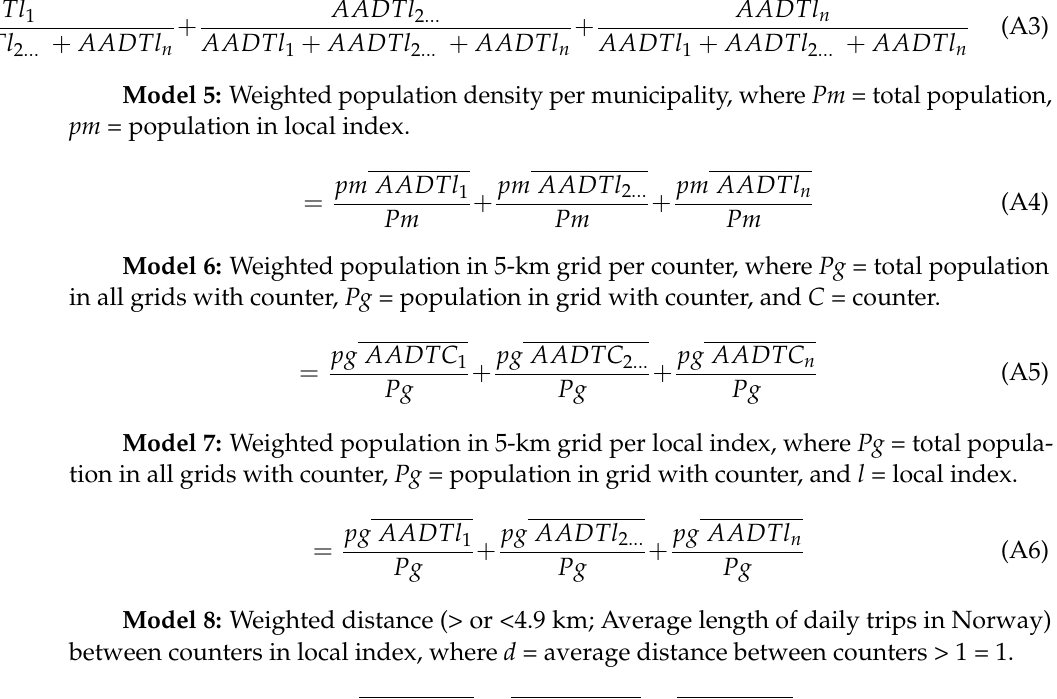
Model 3: Weighted number of counters within the local index. When there are one or two counters, the local AADT is multiplied by 1; when there are three or four counters, the local AADT is multiplied by 2; and with more than five counters, the index is multiplied by 3. Model 4: Weighted percentage of volume AADT per local index.